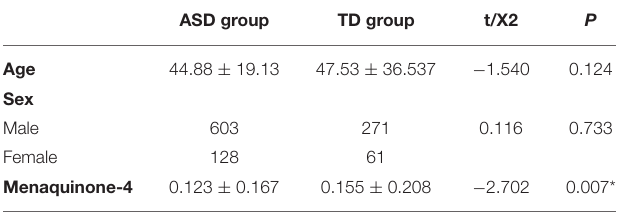
TABLE 2 | Comparison of the distribution of menaquinone-4 levels between the two groups. ASD